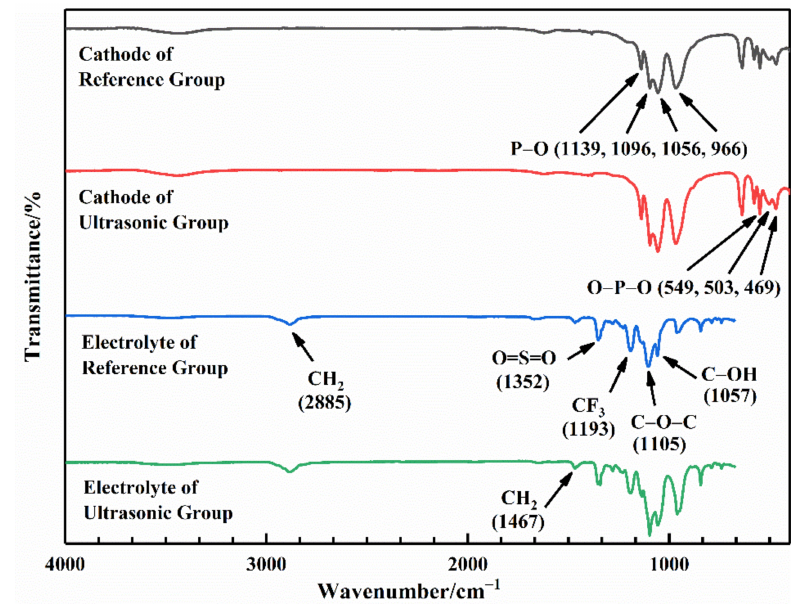
Figure 9. FTIR test results of the electrolyte and the